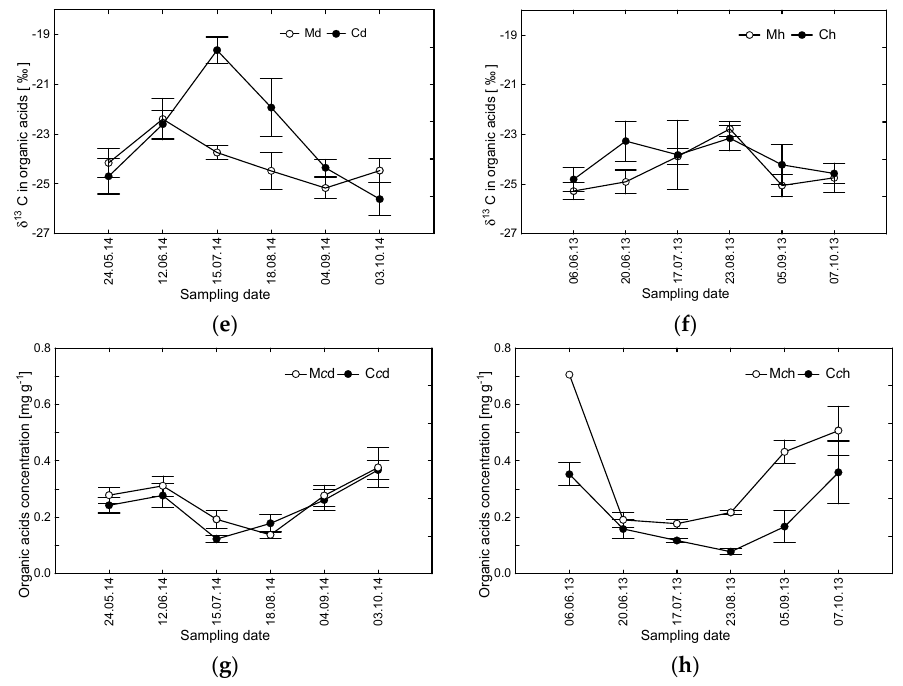
Figure 3. ( a , b ) δ 13 C values of pinitol (P), sucrose (S), glucose (G), and fructose (F); ( c , d ) concentrations (Pc, Sc, Gc, Fc); ( e , g ) δ 13 C values of organic acids (malate, M; citrate, C); ( f , h ) concentrations (Mc, Cc) in needles of declining ( d ) and healthy ( h ) mountain pine trees. Error bars are based on ± 1 SE (standard error).